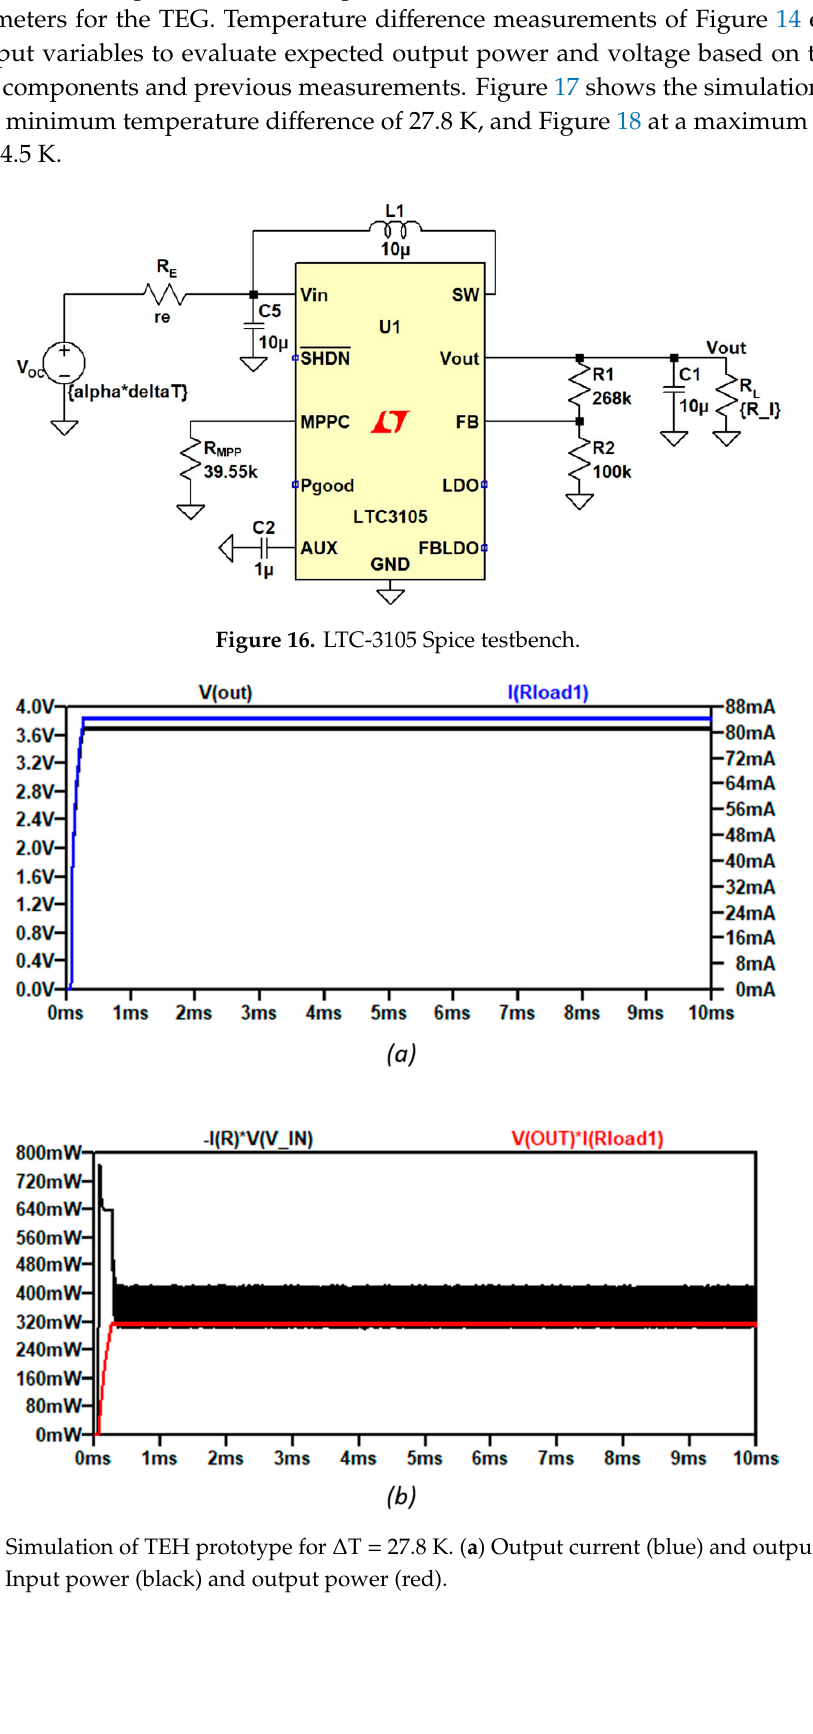
Figure 17. Simulation of TEH prototype for Δ T = 27.8 K. ( a ) Output current (blue) and output voltage (black) ( b ) Input power (black) and output power (red).